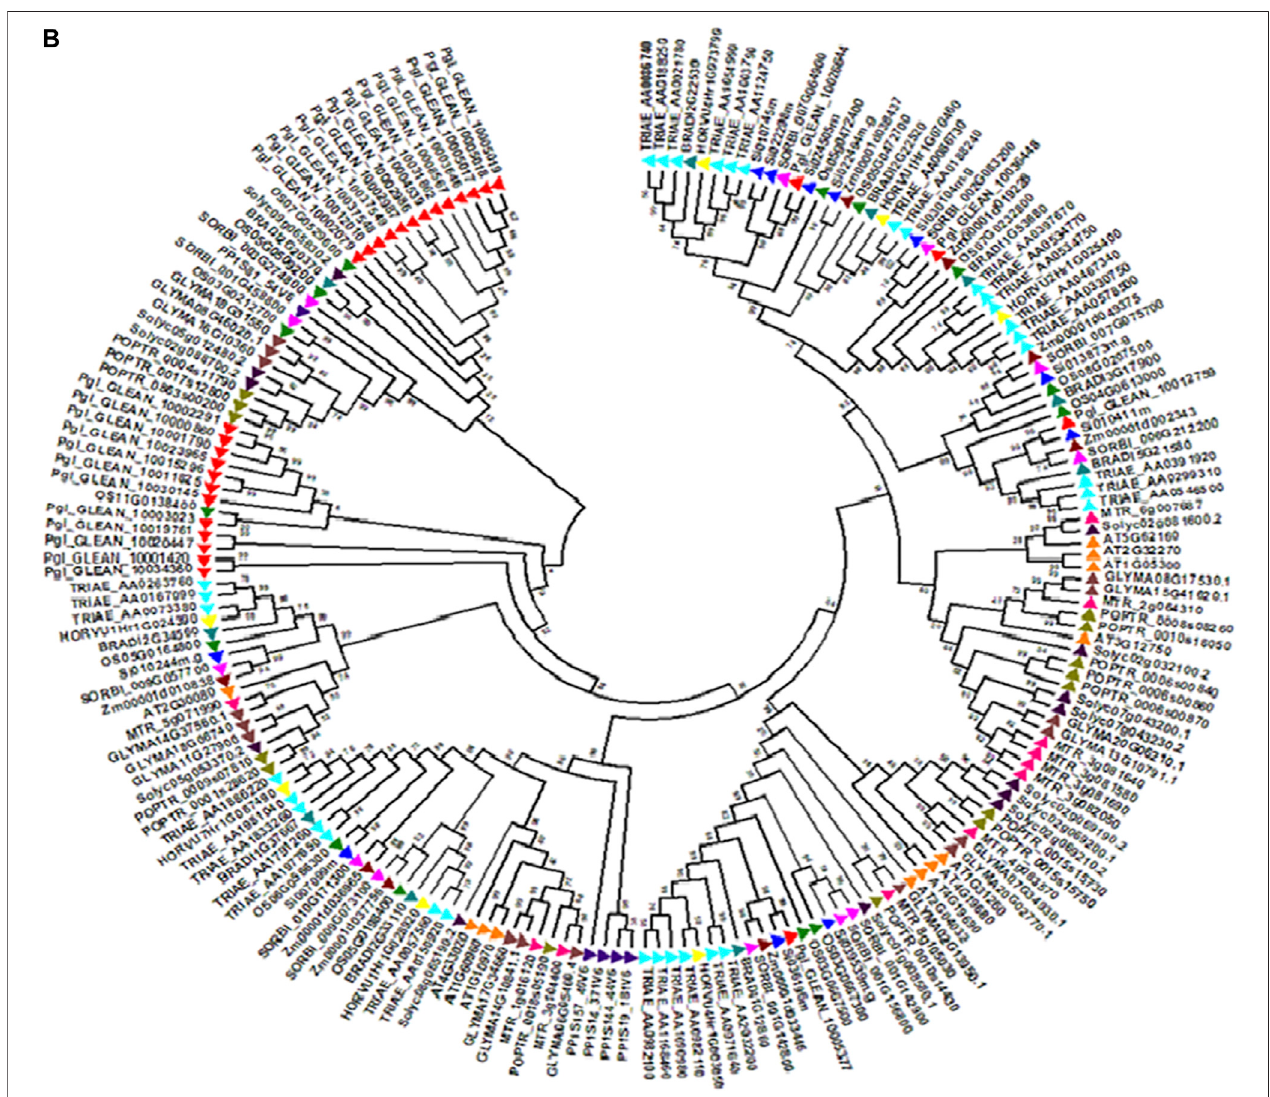
FIGURE 2 | Phylogeny tree of reported 29 pearl millet candidate genes (pre fi x Pgl) for Fe and Zn metabolism with that of other cereal crops showing evolutionary relationship and ortholog events with other cereal crops (Data source: Mahendrakar et al., 2020).